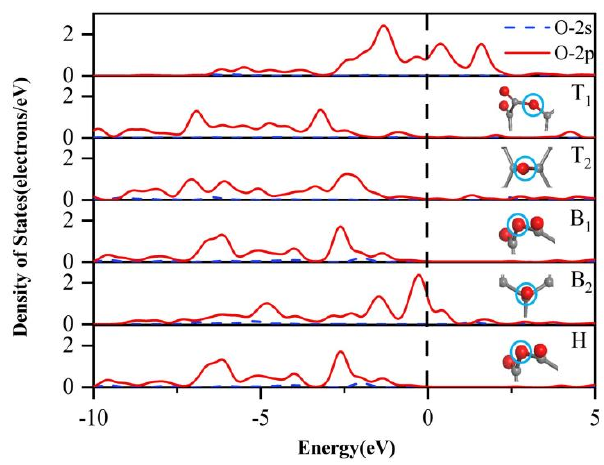
Figure 4. Density of states of O atom adsorbed at different sites on the surface of Model A. To disclose the bonding structure between the adsorbed O atom and the C atom of the anode surface, the density of states of the system was analyzed. Figure 5a,b, respectively, show the total density of states of the system and the projected density of states of oxygen and carbon atoms when oxygen is adsorbed at the surface sites B 1 and T 1 . It can be seen from Figure 5a that the peak near − 24~ − 20 eV mainly come from the hybridization of O 2s and C 2p orbits, and the contribution from − 19~ − 7 eV is almost all from C 2p orbits. The peak near − 7~0 eV is mainly the hybridization of O 2p and C 2p orbitals. O 2p and C 2p orbits between − 7 eV and the Fermi level resonance to form six peaks, and the peak of the total state density here is approximately equal to the sum of the peak of O 2p and C 2p, indicating that the energy level has ionic bond characteristics. In this region, orbits O 2p and C 2p show severe splitting, which aggravates orbital hybridization and thus is favorable for bonding. Therefore, the main bonding behavior between oxygen and carbon comes from the hybridization of O 2p and C 2p orbitals. The same bonding behavior is observed when oxygen is adsorbed at the surface at T 1 , as shown in Figure